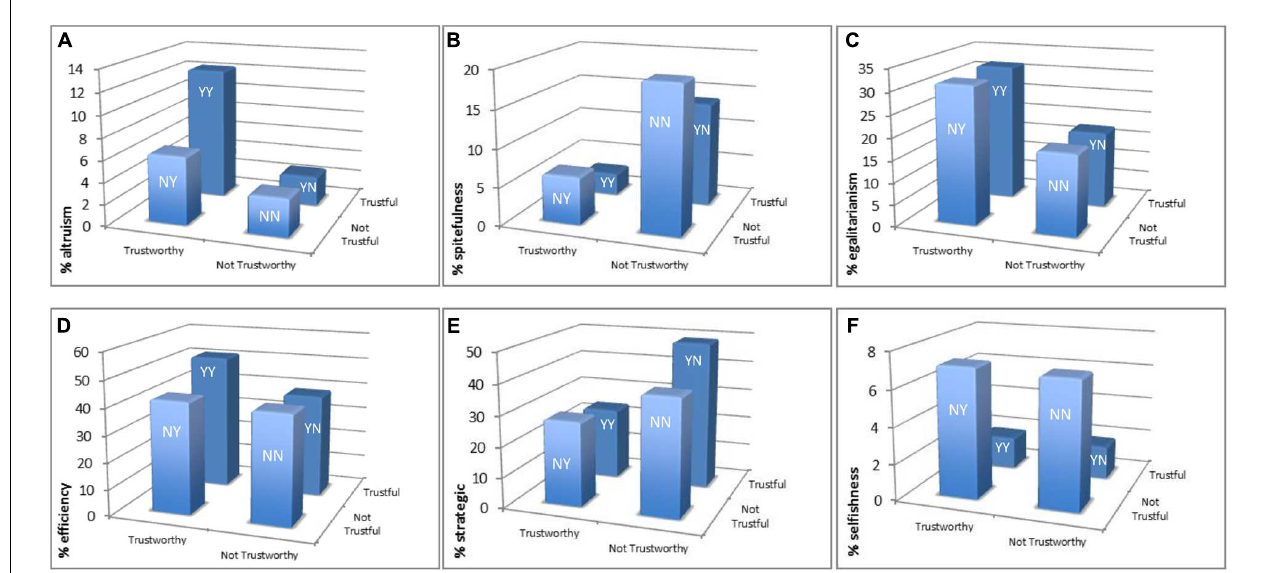
FIGURE 4 | Incidence of each motive profile across TG groups. (A–F) Refer to altruism, spitefulness, egalitarianism, efficiency, strategic self-interest, and narrow selfishness, respectively. The percentages provided refer to the proportion of subjects within each group which can be classified according to each motive type. As can be seen in Figure 1B , the number of observations in each group are 439 in YY, 108 in YN, 112 in NY, and 115 in